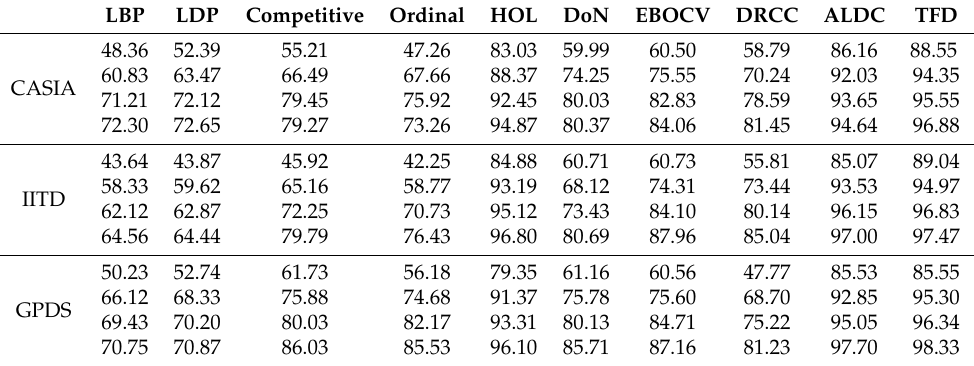
Table 1. The average rank-one identification accuracies of different methods on the CASIA, IITD, and GPDS